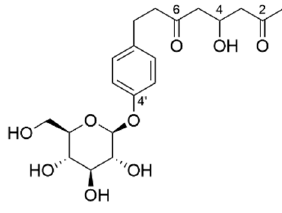
Figure 7. Low energy ESI MS/MS spectrum of taxiphyllin ( 19 ).